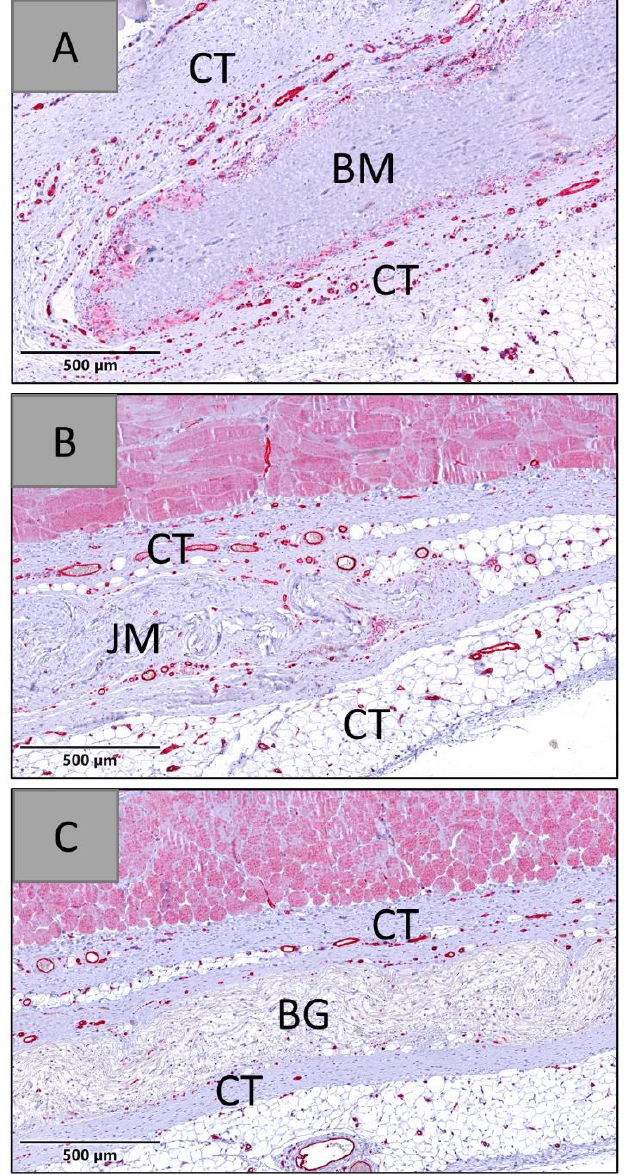
Figure 13. Exemplary histological images of the three membranes within the subcutaneous connective tissue (CT) at day 30 post implantationem. ( A ) BM = native bovine membrane, ( B ) JM = Jason ® membrane, ( C ) BG = Bio-Gide ® , red staining = blood vessels (CD31-immunostainings, 20× magnifications, scalebars = 500 µm).